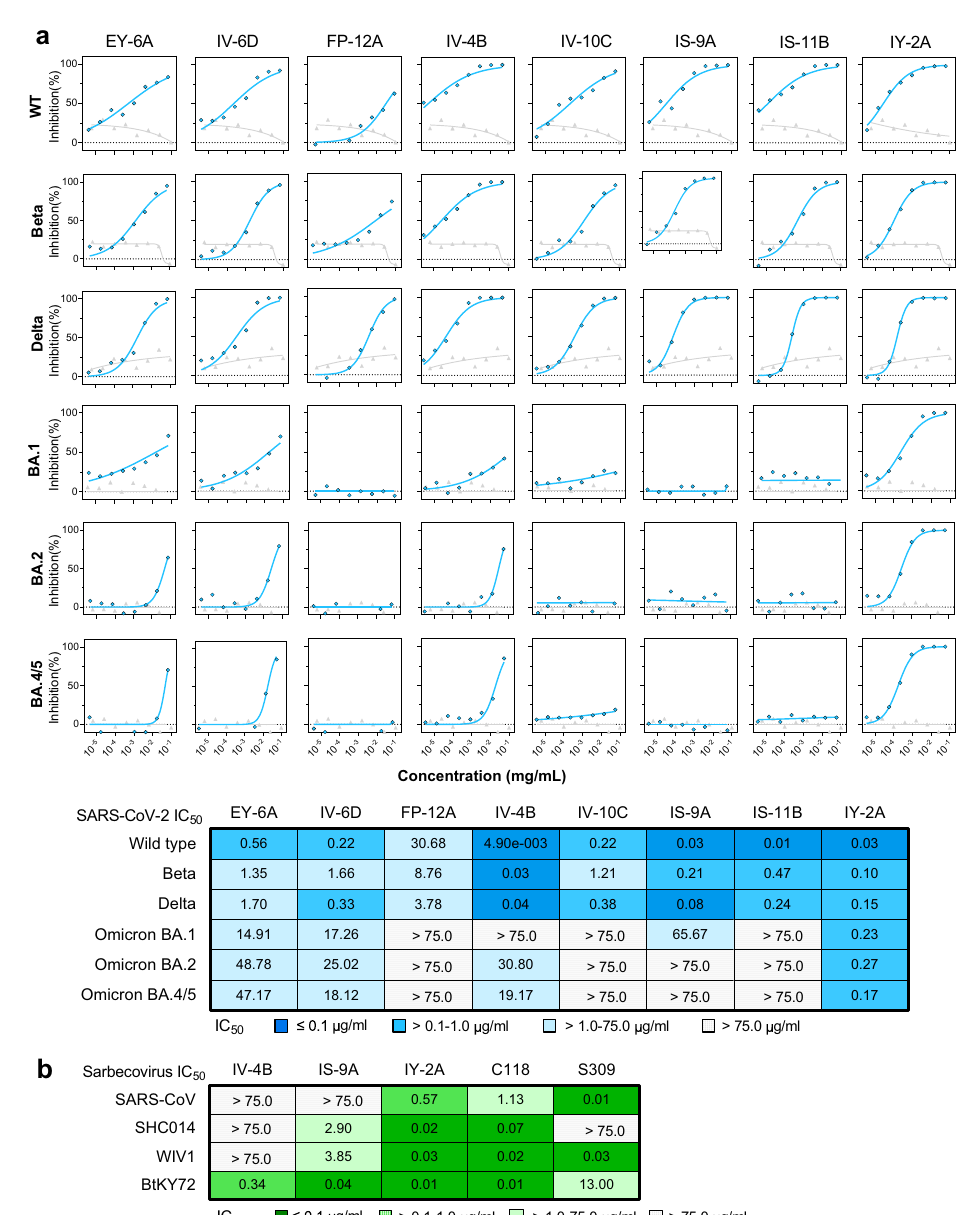
higher the potency, the darker the color. b Neutralization potencies of class 4 antibodies using a pseudovirus-based assay of SARS-CoV and sarbecoviruses. C118 (class4)andS309(class3)areanti-RBDmAbsandareincludedascontrols.TheIC 50 values are summarized for each antibody, with each box colored accordingly. Source data are provided as a Source Data fi